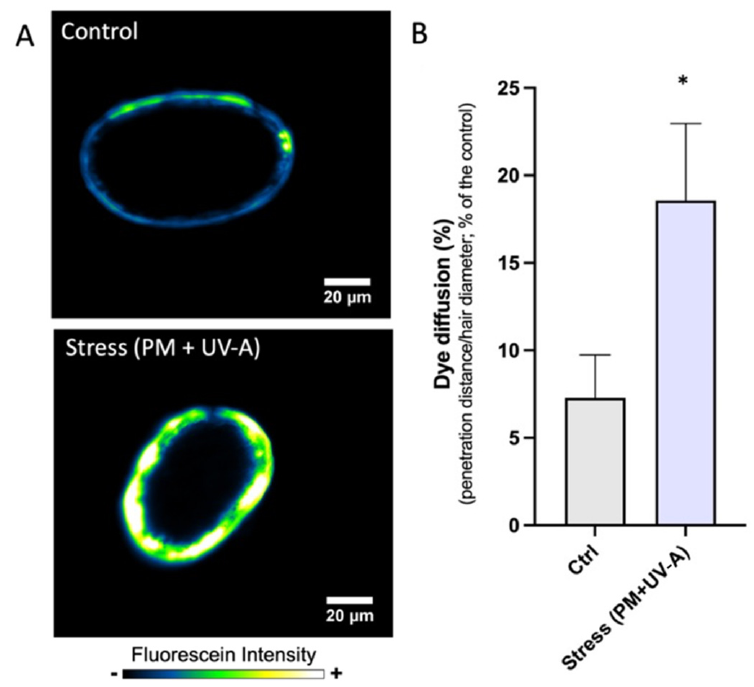
Figure 4. Studies on hair fiber structural integrity. ( A ) Dye diffusion is presented as a color range of fluorescent (from a dark color for low intensity of dye to yellow color for high intensity levels of the dye). ( B ) The diffusion of the dye within the hair fiber is presented here as % of Permeability and obtained from the dye penetration distance along the long axis of hair fiber cross section. Statistics: t-test for binary comparison (unpaired, two-ways, alpha = 0.5; * p < 0.05.